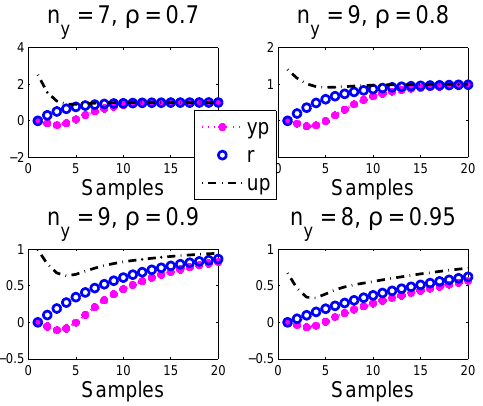
Figure 12. Closed-loop step responses for a third order system G with the underlying target trajectory.